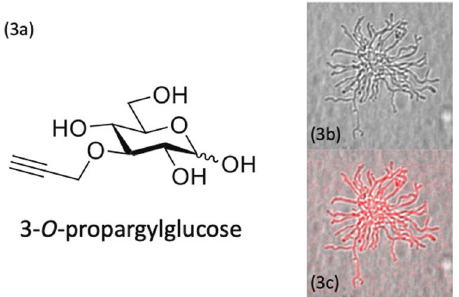
Fig. 3 Using click-labeled glucose to track nutrient uptake. The click-labeled glucose analogue O -propargylglucose ( a ) can be used as a sole carbon source to support fi lamentous growth of the multicellular bacterium Streptomyces coelicolor ( b ). The image in ( c ) shows the same colony after staining with AlexaFluor647-Azide. All images were taken with a Zeiss Z1 Airyscan with a 40× wet objective (images provided by Niels